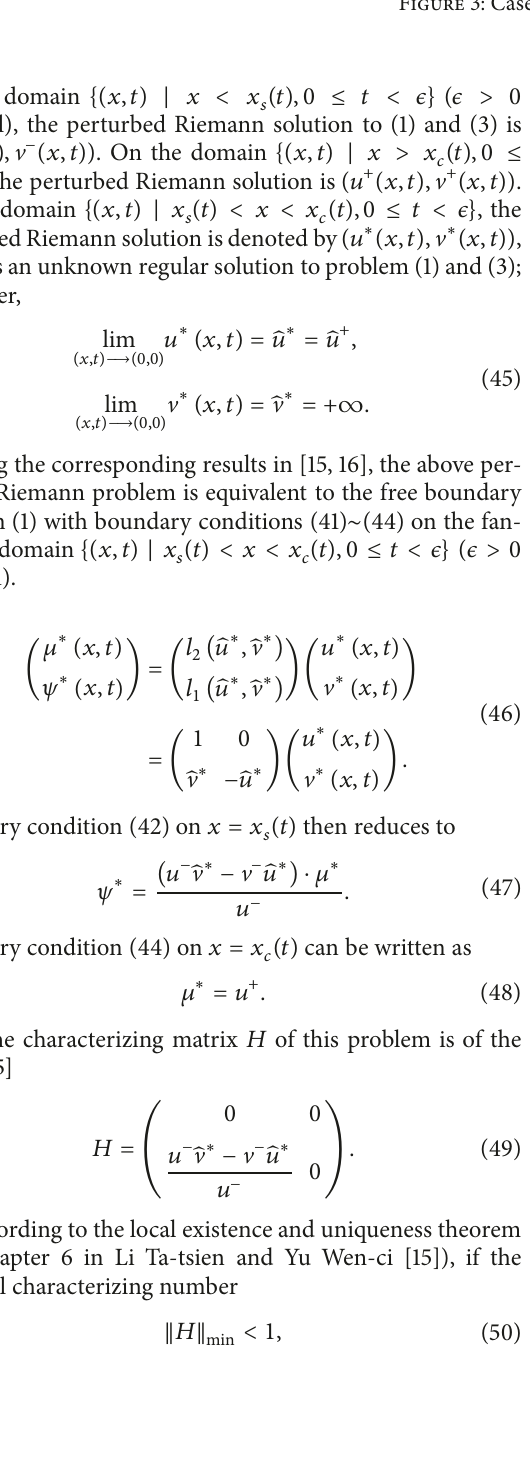
Figure 3: Case 2 with ̇𝑢 − 0 (0) > 0